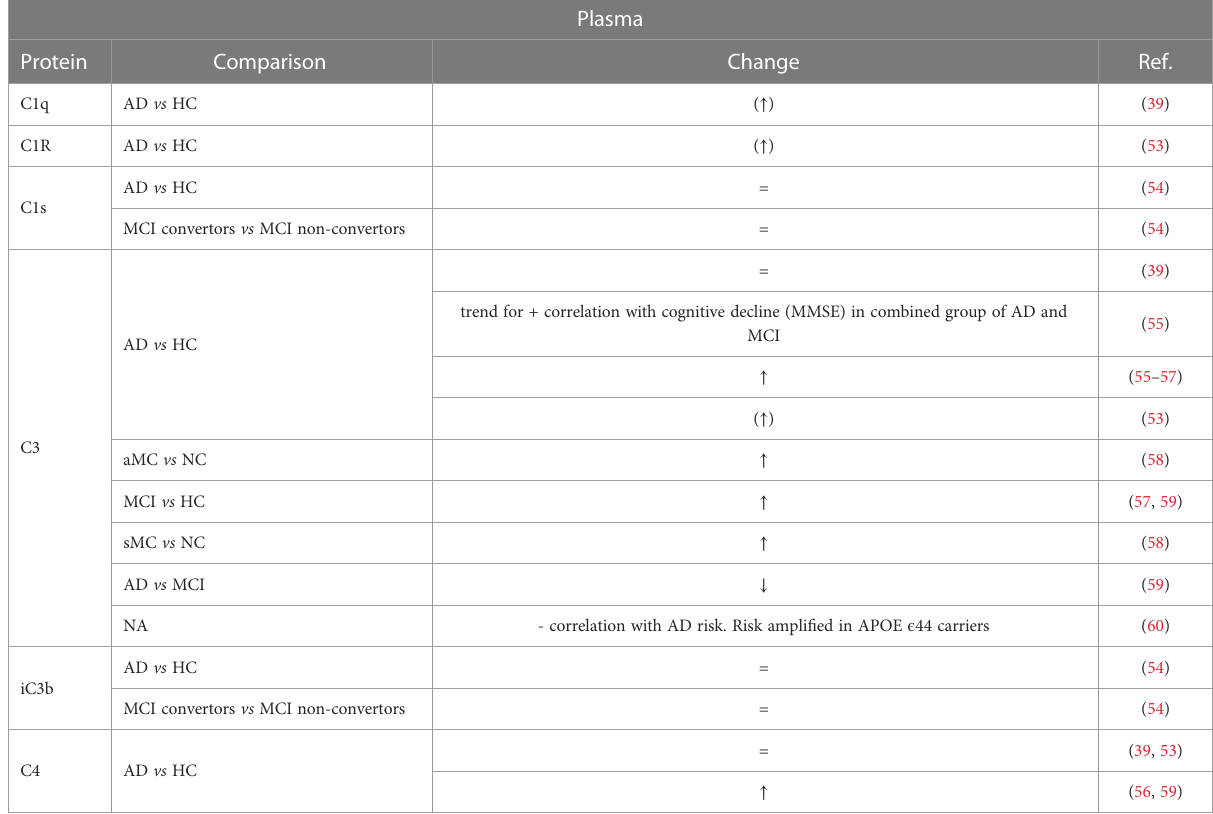
TABLE 2 Overview of changes and biomarker potential of complement proteins in the plasma of Alzheimer ’ s disease (AD) and mild cognitive impairment (MCI) patients compared to a control group.